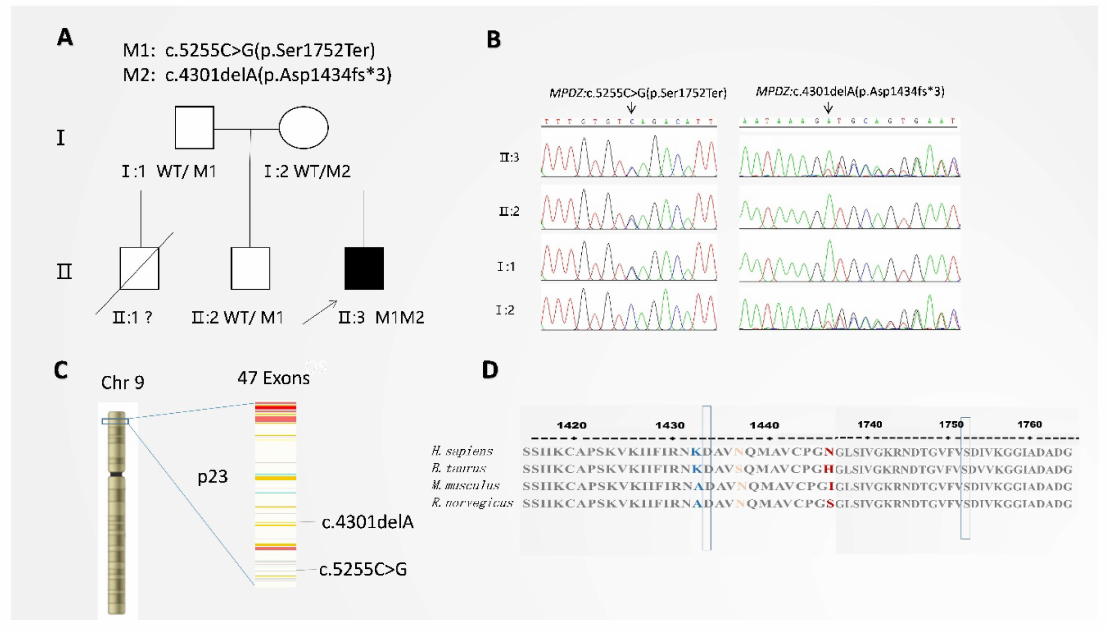
Figure 1. Validation of the mutation. ( A ) Pedigree information. In this pedigree, filled symbols indicate affected patients with MC. The unfilled symbols indicate unaffected individuals. An oblique line indicates a deceased person. Squares denote males, and circles denote females. M1